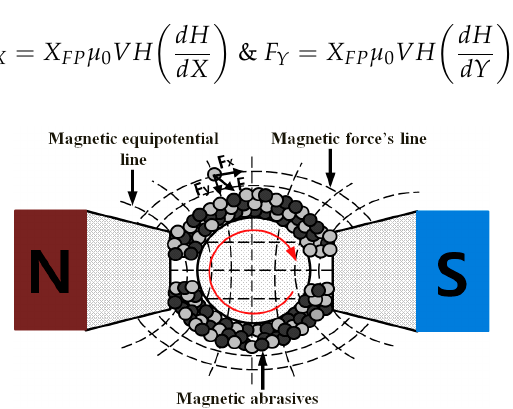
Figure 2. Two-dimensional magnetic force field lines holding particles operating on the workpiece [11].